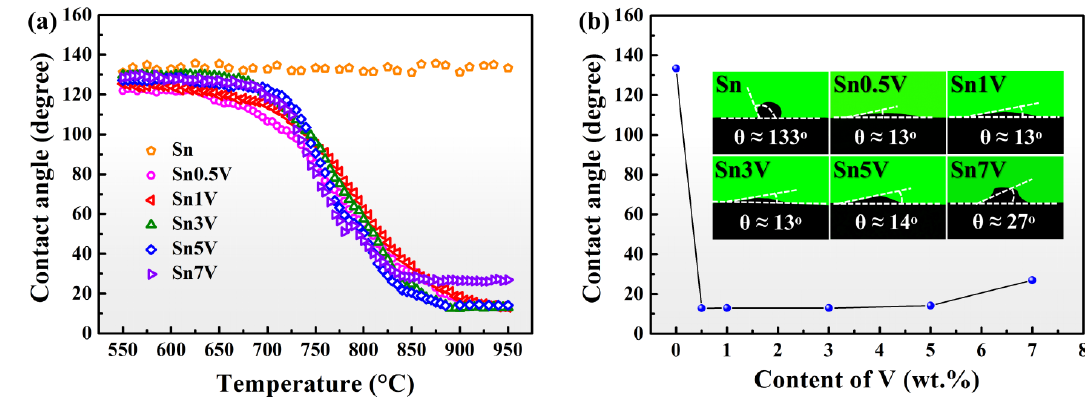
Figure 3. ( a ) Plotting of apparent contact angles of Sn- x V ( x = 0, 0.5, 1, 3, 5, 7, in wt.%) alloys versus continuous increase of wetting temperatures; ( b ) Plotting of final apparent contact angles against nominal V contents and corresponding images of intersections of the samples at 950 °C.